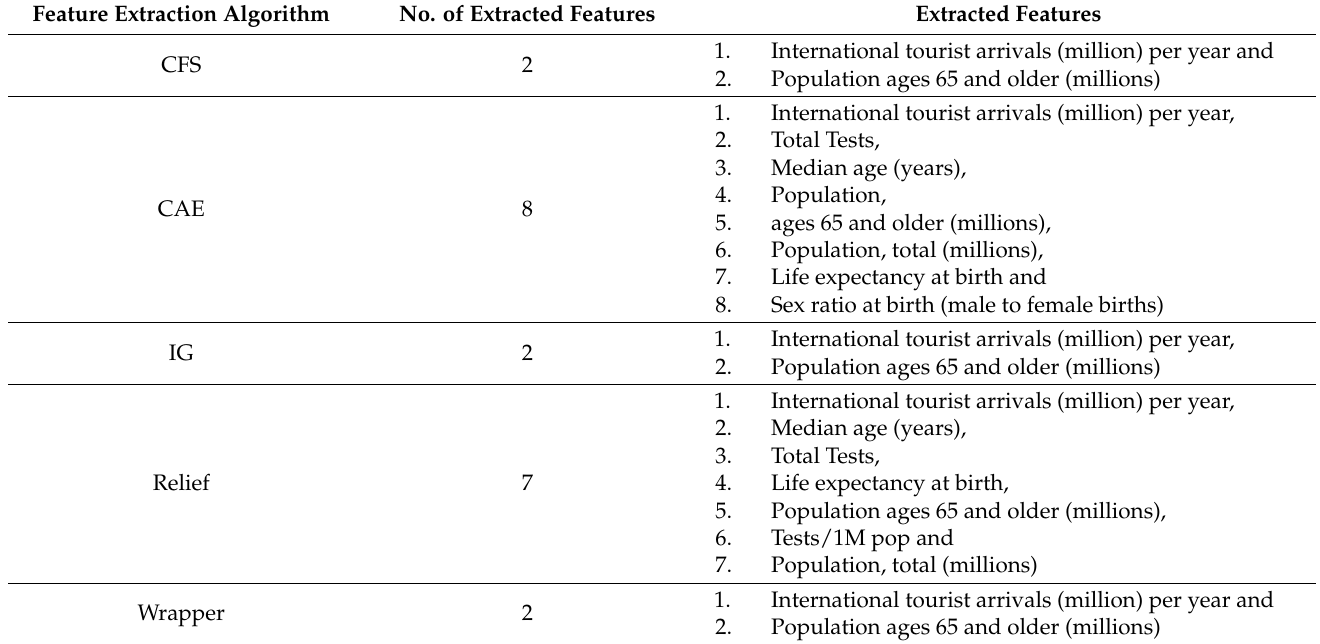
Table 13. The ranked features of the feature extraction algorithms to predict the total critical